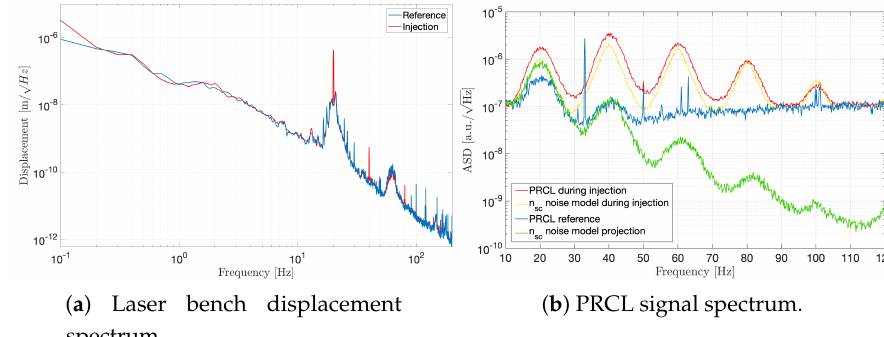
Figure 4. Shaking test of laser bench. In both sub-figures the blue curve corresponds to quiet conditions, the red curve is when applying a 20 Hz sinusoidal excitation to the laser bench. ( a ): the bench displacement signal in quiet condition and during the excitation. ( b ): power recycling cavity length signal (PRCL) signal and scattered light model using C = 8 × 10 − 6 are shown. Yellow and green curves show the model during the shaking of the bench and quiet condition, respectively.